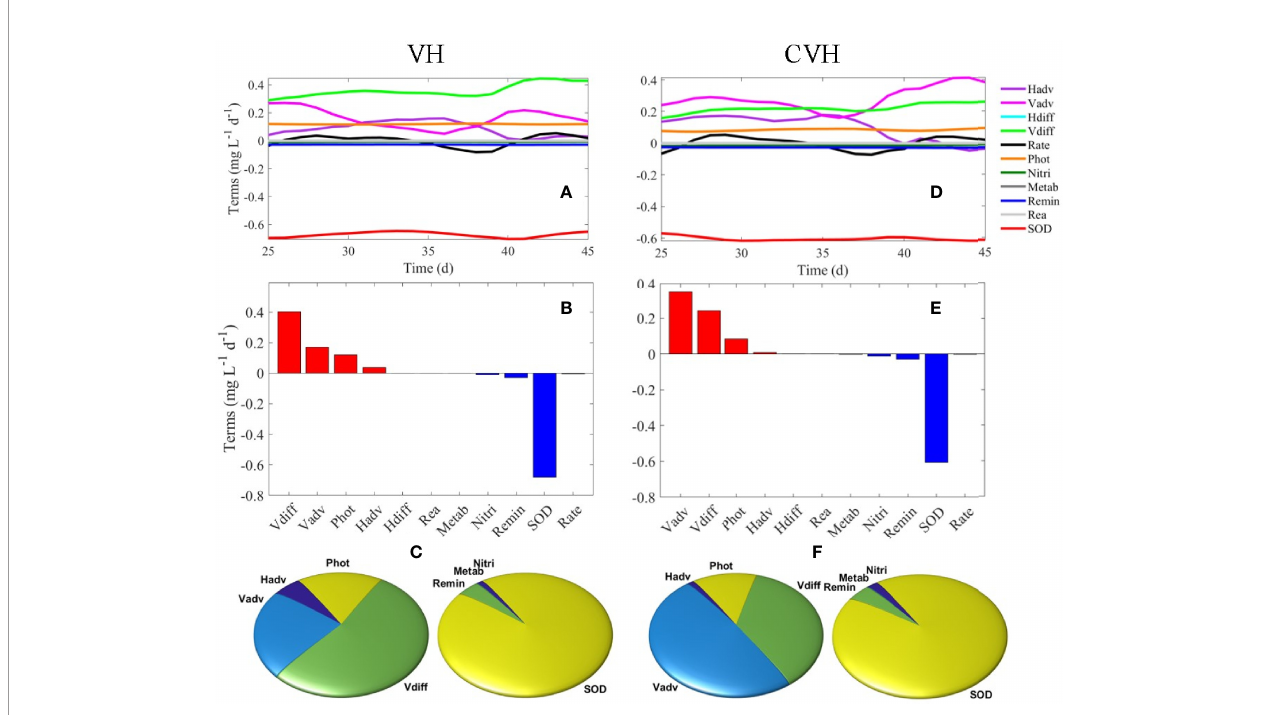
FIGURE 9 | (A) Time-series of DO terms in the bottom layer of VH, (B) average DO terms from day 38 – 45 of VH in bottom layer, (C) percentage for DO source (left) and sink (right) terms of the VH in the bottom layer. (D – F) are the same as (A – C) but for the